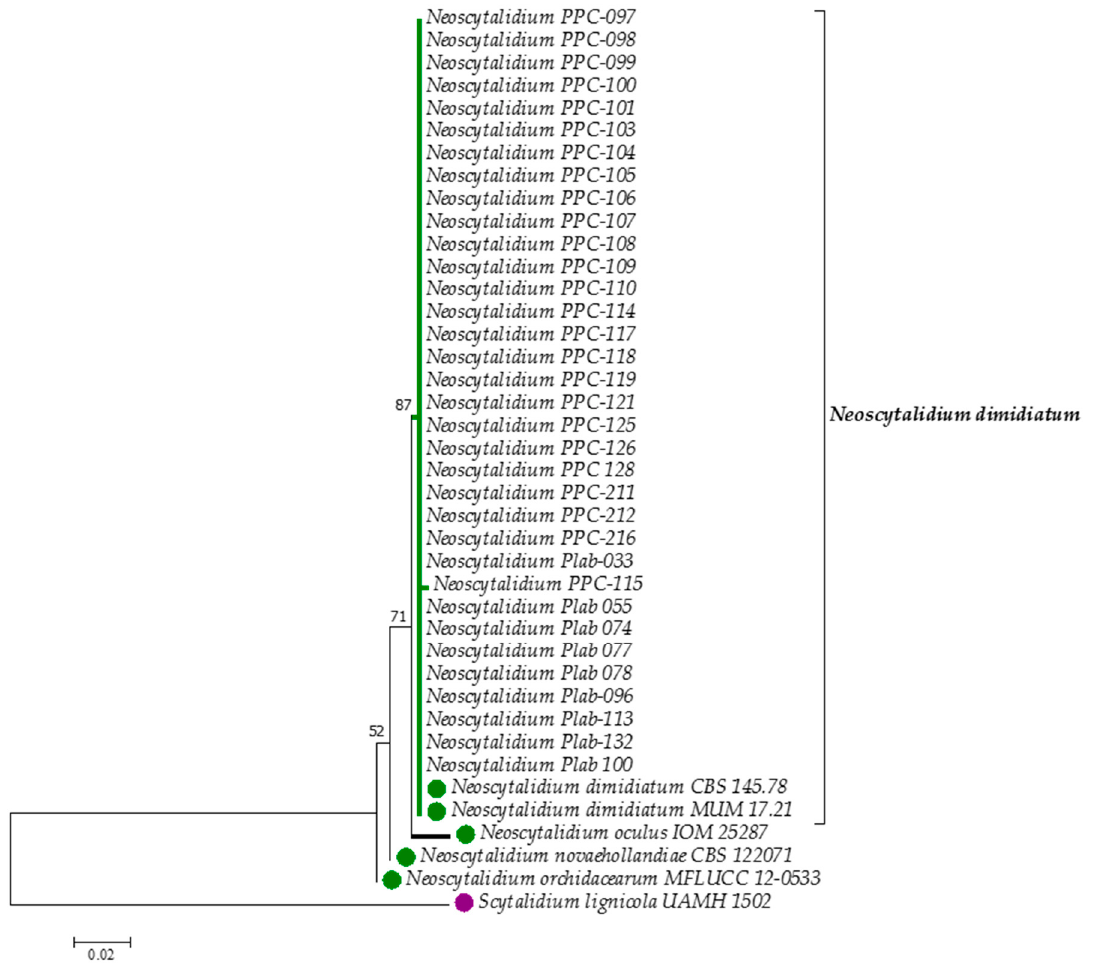
Figure 1. Consensus tree constructed using the maximum likelihood method with the ITS1+5.8S+ITS2 rDNA sequences of 34 clinical isolates of N. dimidiatum , five reference sequences of Neoscytalidium species (green circles), and one sequence of S. lignicola as the outgroup (purple circle). Percentage bootstrap values (1000 replicates) are shown next to the respective branches. Scale bar indicates nucleotide substitutions per site.